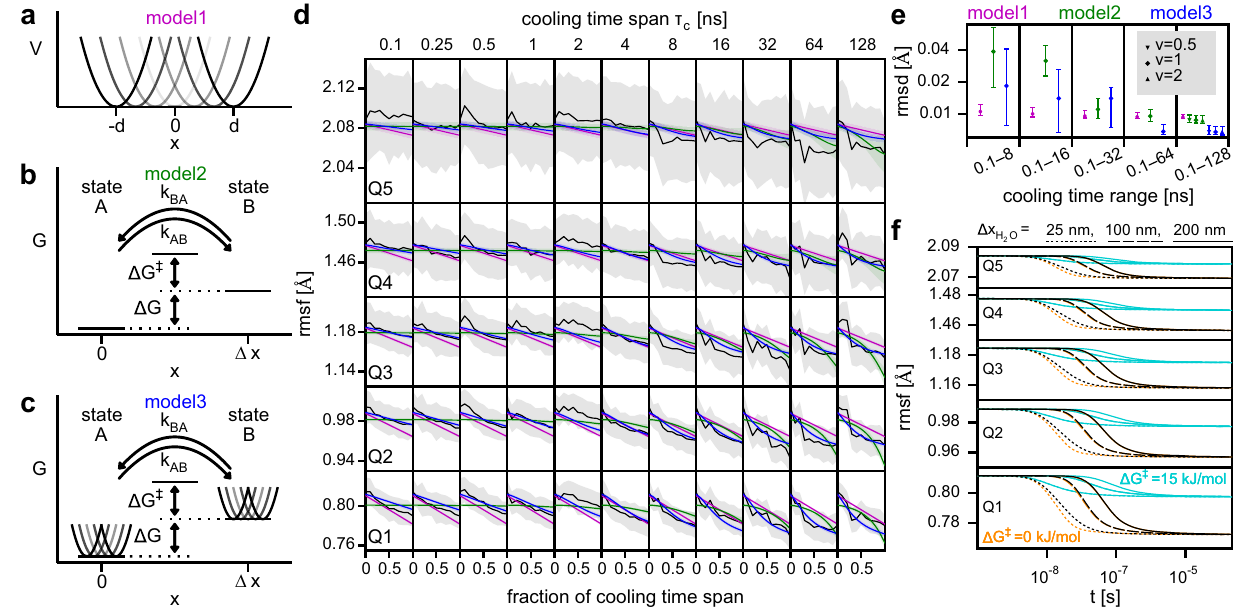
Fig. 3 Models of cooling behavior. Schematics of thermodynamic model1 with uniformly distributed harmonic potentials ( a ), kinetic two-state model2 ( b ), and combined model3 ( c ). d Comparison of the time dependence of the rmsf quantiles obtained from T-quench simulations after rescaling (black lines, compare Fig. 2c) with those obtained from the models (magenta, green, and blue lines). Standard deviations from simulations and the models are shown as gray and colored areas, respectively. e For each model, the root mean square deviation (rmsd) of the predicted rmsf values from the rmsf values obtained from the T-quench simulations (d, black lines) is shown. Rmsf values were obtained from 41 simulations for each cooling time span. To obtain model parameters, the T-quench rmsf values for different ranges of cooling time spans were used (0.1 – 8 ns, 0.1 – 16 ns, … ). The symbols denote the mean values and the vertical lines correspond to the 95% con fi dence intervals obtained from the parameter distributions. f Rmsf decrease during plunge freezing as a function of time for the quantiles estimated from combining model3 with temperature drops (Fig. 1c) for different water-layer thicknesses ( Δ x H